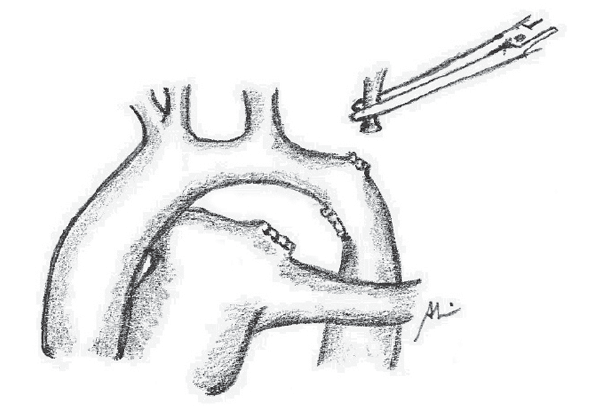
Fig. 5- Secção da artéria subclávia esquerda